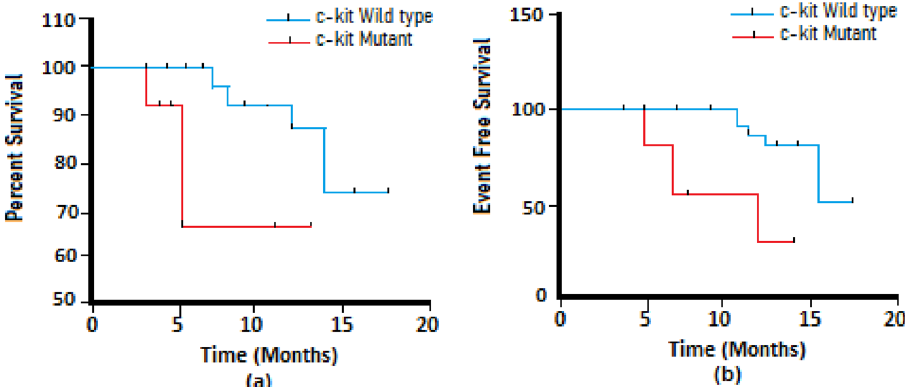
Figure 4. Effect of c-kit mutations on prognosis of AML patients. Low overall ( a ) and Event free survival ( b ) in c-kit mutant and non mutant patients was observed in Kaplan Meier analysis.